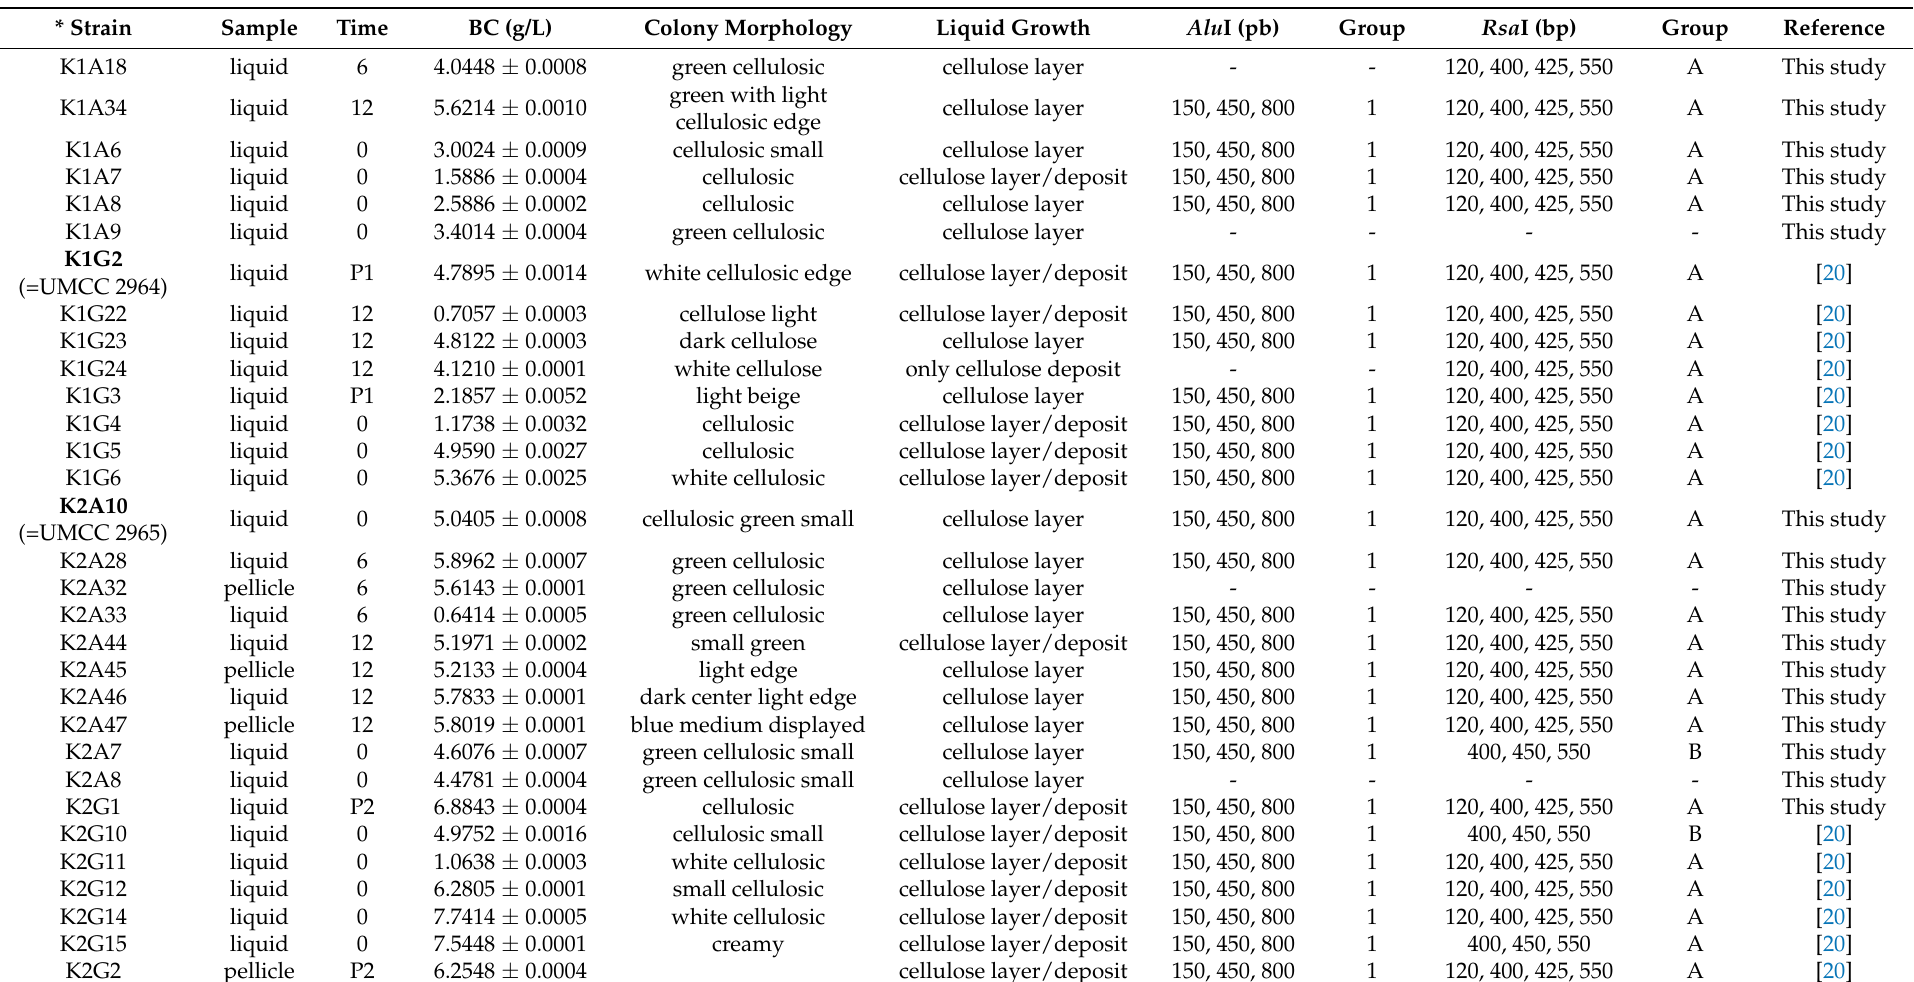
Table 1. Features of 46 isolates from Kombucha tea used in this study. Site of isolation and RFLP analysis. In bold are reported the strains deposited in UNIMORE Microbial Culture Collection (UMCC) collection; within the brackets is the assigned accession